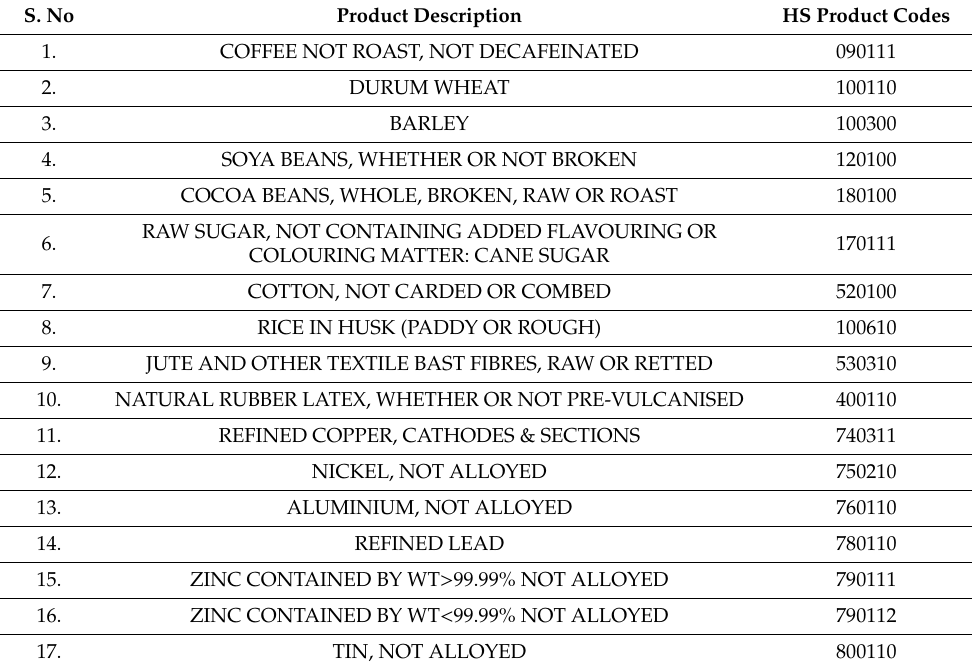
Table 2. Country-Wise List of Primary Commodities with HS